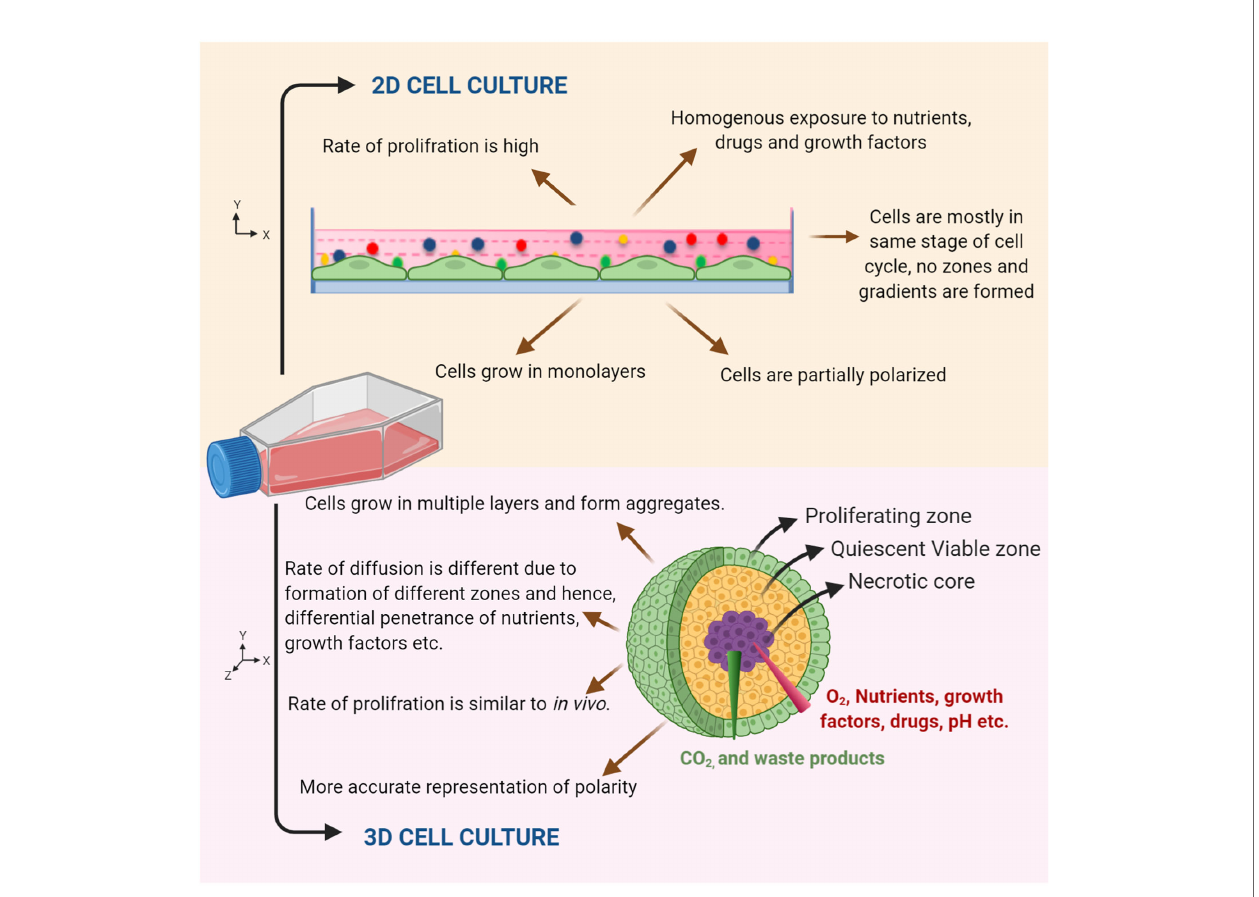
FIGURE 3 | Characteristic features of 2D and organoid culture. Schematic representation showing cells grown in 2D monolayer culture and in 3D culture. An organoid mimics the tumor microenvironment by forming different zones (viz. proliferating zone, quiescent viable zone, and necrotic core) and gradients, which gives a realistic response compared to 2D monolayer